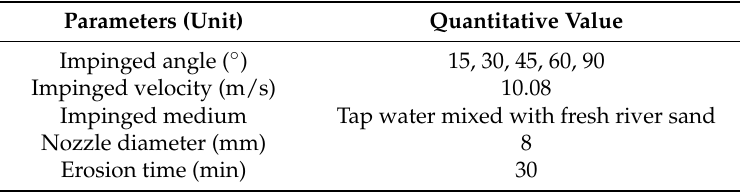
Table 1. Parameters employed for slurry erosion testing.